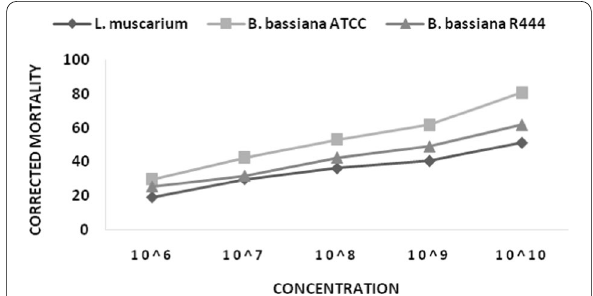
Fig. 3 Corrected mortality of 2nd instar Tuta absoluta larvae from by the second method with Beauveria bassiana ATCC, B. bassiana R444 and Lecanicillium muscarium